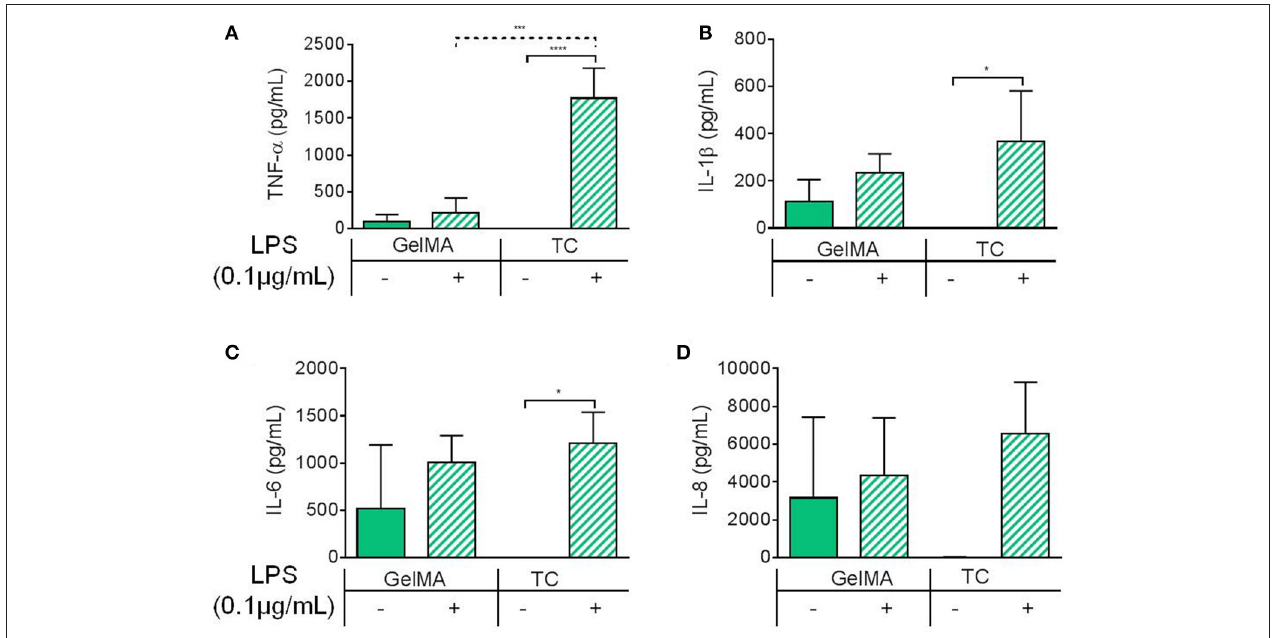
FIGURE 2 | Inflammatory cytokine production by PBMCs cultured on GelMA hydrogels. Soluble cytokine production after 4h by PBMCs cultured on GelMA hydrogels or TC, with ( + ) or without (–) LPS stimulation. (A) TNF- α was not significantly increased following LPS stimulation in GelMA cultures. Secretion of TNF- α , into the cell culture medium, was found to increase significantly in the LPS-stimulated TC control (**** P ≤ 0.0001). A significant difference in the level of LPS-induced TNF- α production was found between GelMA and TC conditions (*** P ≤ 0.001). (B) Production of IL-1 β was not significantly increased with LPS stimulation in the presence of GelMA, whereas in TC it was (* ≤ 0.05). (C) IL-6 secretion was not significantly increased in GelMA cultures following LPS stimulation, this was found to be significant in TC (* P ≤ 0.05). (D) No significant rise in IL-8 production with LPS stimulation GelMA or TC cultures ( P ≥ 0.05). One-way ANOVA performed to determine statistically significant differences in cytokine production ( n = 3 independent experiments). Error bars represent standard deviation. ** p < 0.01.